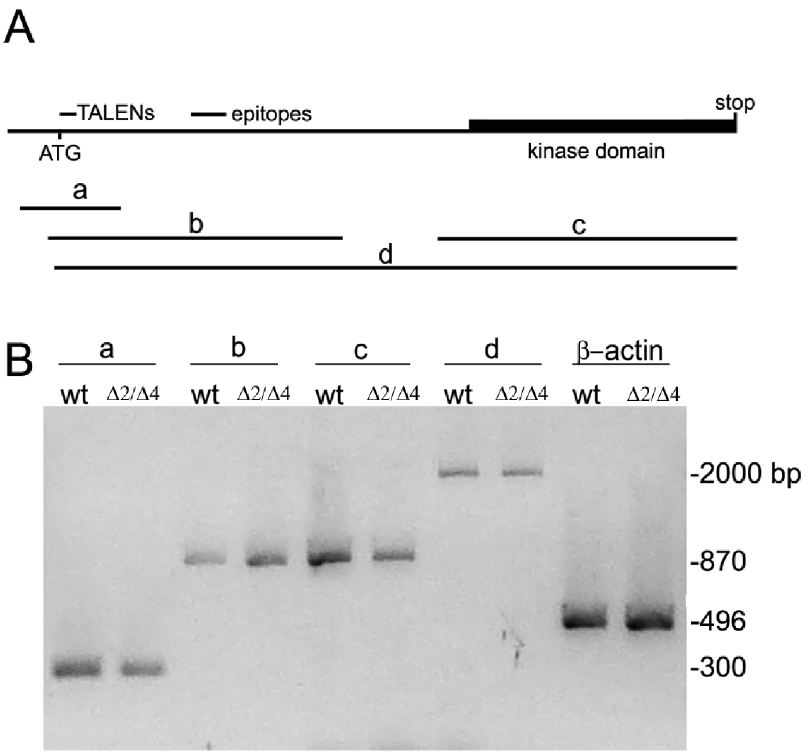
Figure 3. Testing for other possible forms of expressed pak4 by RT-PCR. (A) Positions of amplicons a–d corresponding to pak4 cDNA. a: 5 9 - UTR and 5 9 -end of coding region; primers F17 and R3. b: region amplified by primer pair (MO1F and MO3R) annealing to the target sites for the translation-blocking MO and splice MO1. c: region encoding kinase domain; primers F7 and R2. d: complete open reading frame; primers F2 and R2. TALEN mutation site and epitope site were indicated. (B) Agarose gel electrophoresis of amplicons a–d using cDNAs extracted from wild type (wt) and F 3 pak4 mixed null ( D 2/ D 4) embryos at shield stage as template. b -actin was used as control.